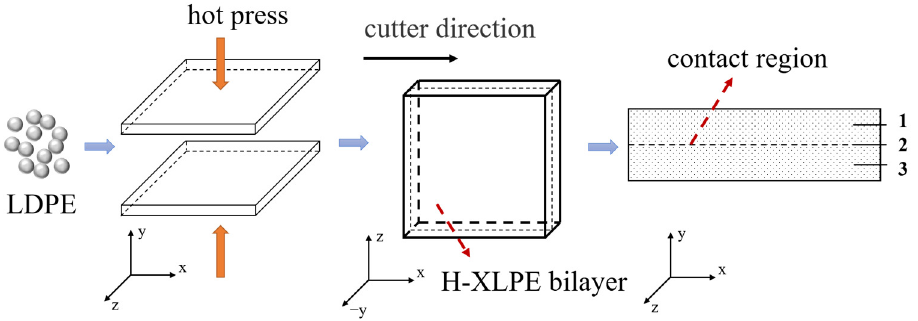
Figure 1. Schematic diagram showing the sequence of specimen